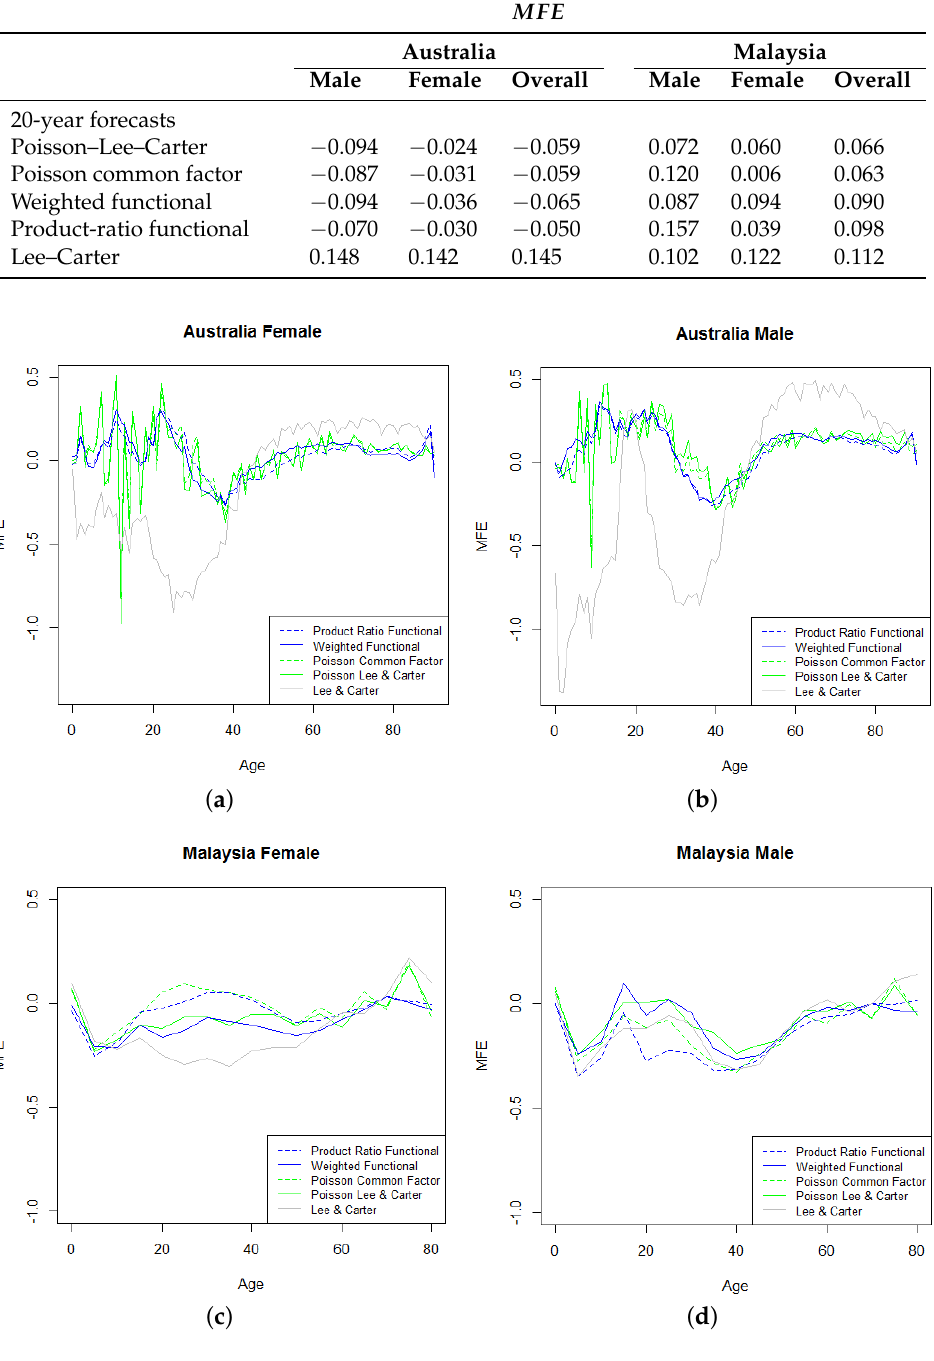
Figure 3. Mean Forecast Error ( MFE ) by age and methods for ( a ) Australian females, ( b ) Australian males, ( c ) Malaysian females and ( d ) Malaysian